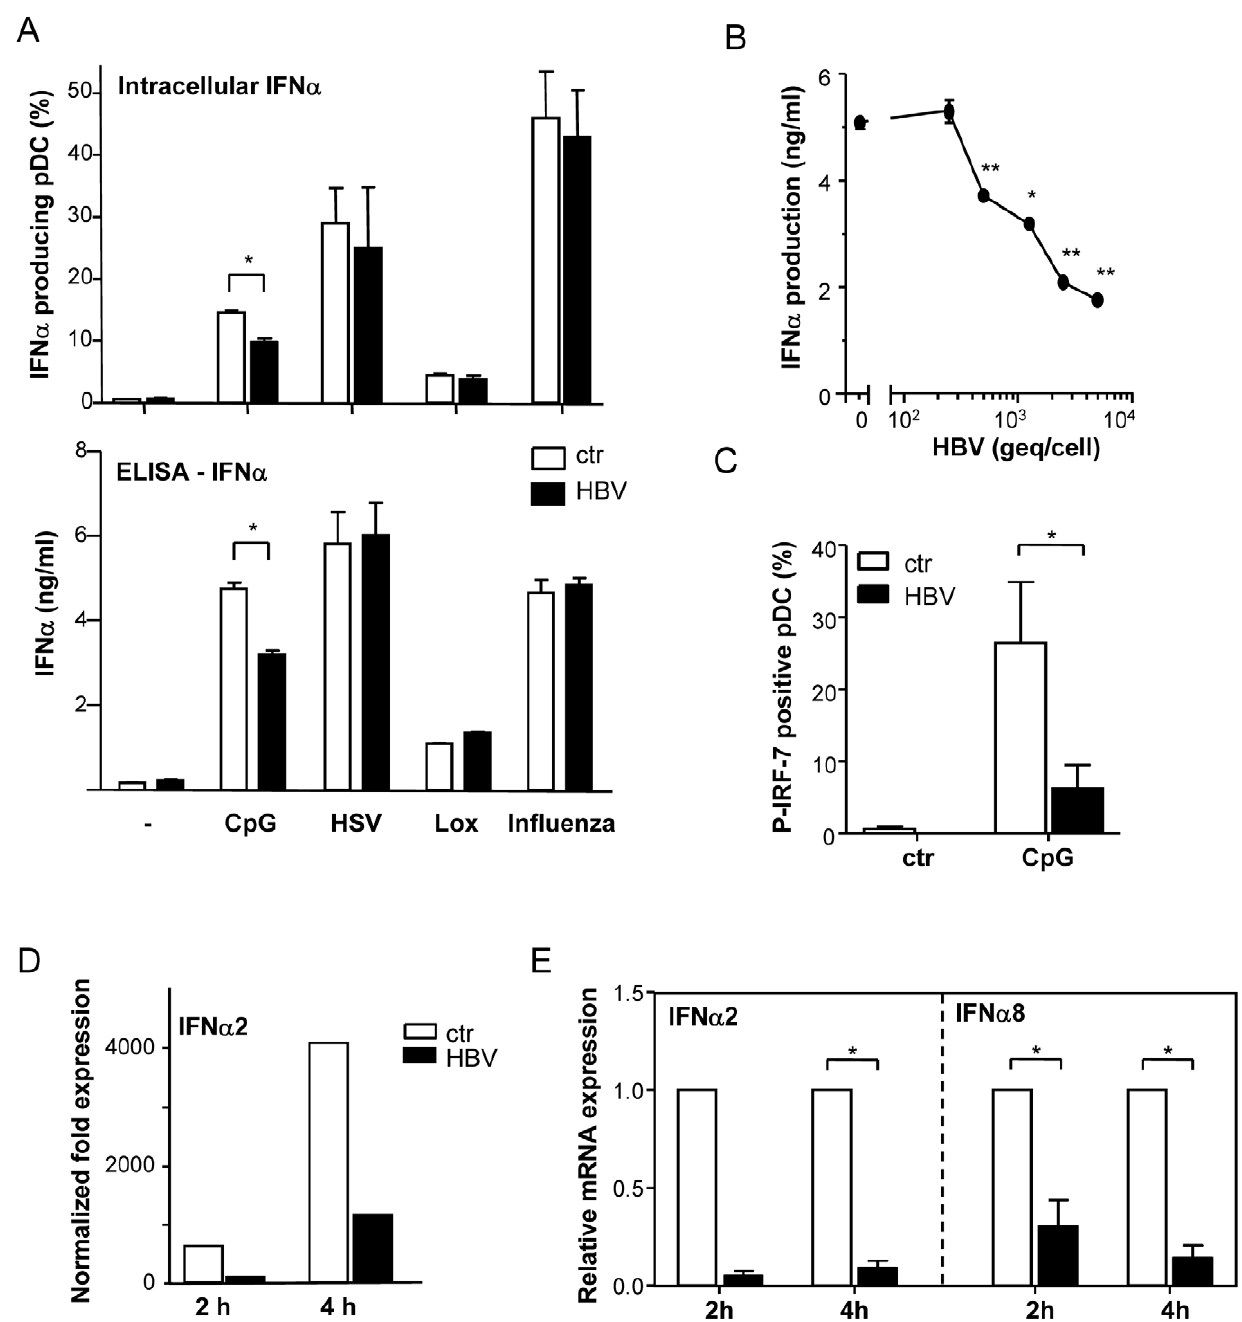
Figure 2. HBV dose-dependently inhibits CpG-induced transcription of IFN a in pDC. A : IFN a production by pDC cultured in medium, CpG, HSV-1, Lox or Influenza with or without HepG2.215-derived HBV was determined by flow cytometry or ELISA. Mean 6 SEM of 3 independent experiments. B : CpG-activated pDC were cultured with different doses of HepG2.215-derived HBV. IFN a production determined by ELISA is presented as mean 6 SEM of 16 independent experiments with different donors. C : pDC were cultured with CpG in the presence or absence of HepG2.215- derived HBV for 3h. Data present the mean 6 SEM percentage of cells positive for phosphorylated IRF7 from 5 independent experiments. DE : pDC were cultured with CpG in the presence or absence of HepG2.215-derived HBV for 2 or 4h. Data represent IFN a 2 ( DE ) and IFN a 8 ( E ) mRNA levels normalized to GAPDH and are representative for 6 experiments ( D ) or show the mean 6 SEM IFN a mRNA levels relative to cultures without HBV (n=6) ( E ). *p , 0.05, **p , 0.01, p , 0.001, Wilcoxon signed rank test.